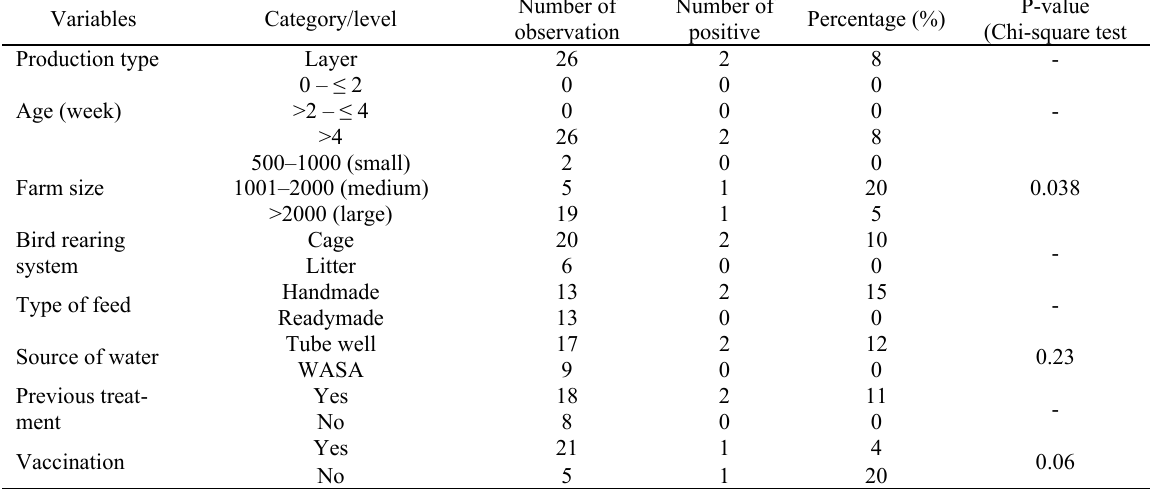
Association of different variables with samples positive in Direct Microscopic Examination